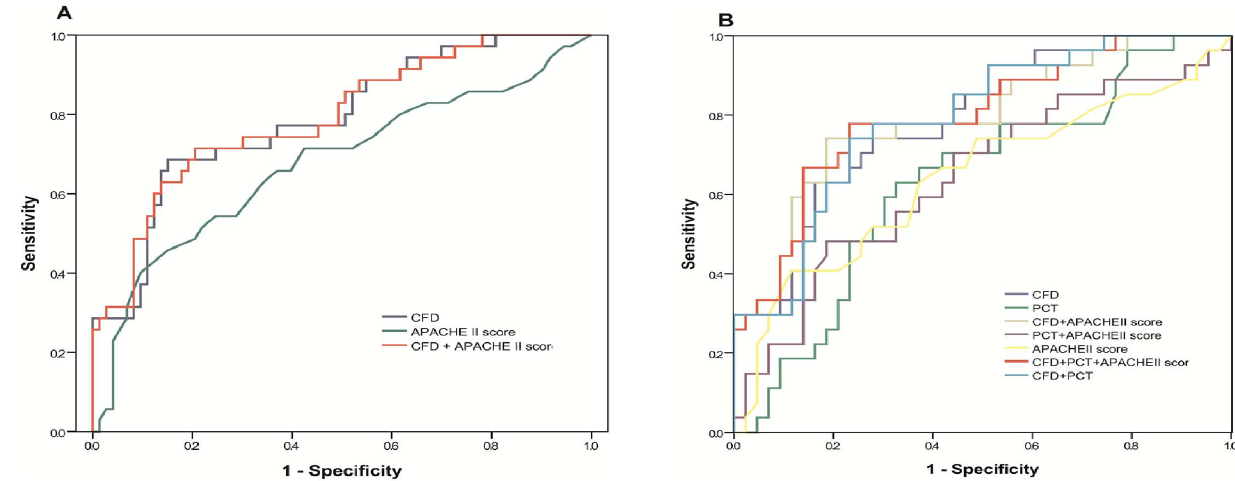
Figure 2. ROC curve of CFD levels and APACHE II score as predictors of in-hospital and 28-day mortality (A). CFD P-value for trend: p , 0.001, PCT P-value for trend: p=0.109. Score: CFD ; AUC=0.79 (0.69–0.68), P , 0.05 compared to APACHE II, IDI=0.14 (0.03–0.25). APACHE-II + CFD ; AUC=0.79 (0.70–0.89), P , 0.05, IDI=0.18 (0.09-0.28). APACHE-II ; AUC=0.68 (0.56–0.79), Reference. ROC curve of CFD levels, PCT levels and APACHE II scores as predictors of in-hospital and 28-day mortality (B). Score: CFD ; AUC=0.79 (0.68–0.90), P , 0.05 compared to APACHE II, IDI=0.16 (0.04–0.29). PCT ; AUC=0.63(0.50–0.77), P . 0.05, IDI= 2 0.04 (0.01–0.10). APACHE-II + CFD ; AUC=0.80(0.68–0.90), P , 0.05, IDI=0.20(0.09– 0.31). APACHE-II + PCT ; AUC=0.65(0.51–0.78), P . 0.05, IDI=0.01(0.01–0.02). APACHE-II + CFD + PCT ; AUC=0.80(0.69–0.91), P , 0.05,